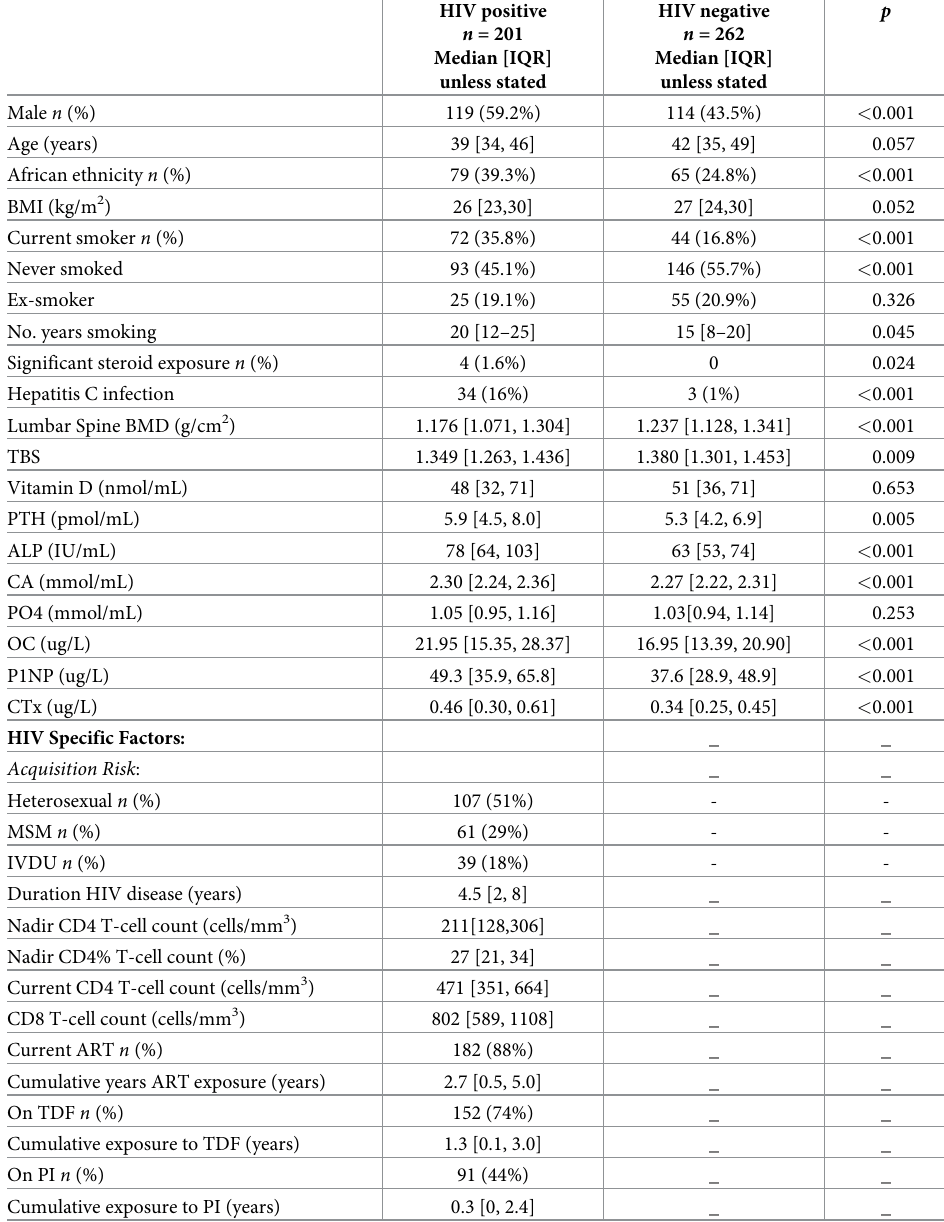
Table 1. Baseline characteristics of participants in the HIV UPBEAT